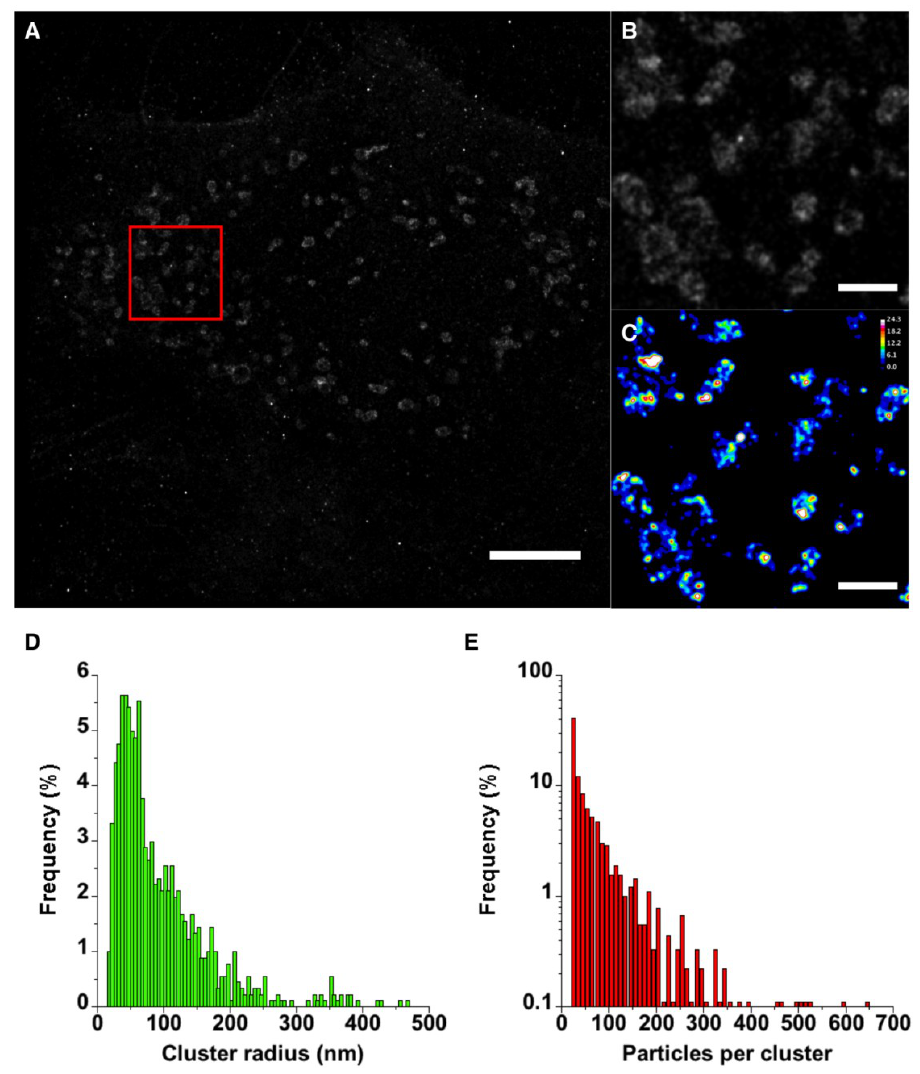
Figure 8. PALM imaging of vMIA-PAmCherry1. HFFs were transfected with vMIA-PAmCherry and imaged by PALM. ( A ) The image shows 301666 molecules that were localized to ≤25 nm precision out of 515207. Molecules are plotted as two-dimensional Gaussian distributions with 25 nm standard deviations. ( B ) The image shows a small region in ( A ) indicated by the red square. The molecule positions in a binary image were used in pair correlation analysis and the maximum g(r) derived from using each molecule as a reference point was plotted as the pixel values. ( C ) The image shows the same region in the red square color-coded to display the varying degrees of molecule densities. The Look Up Table (LUT) and calibration bar are included in the upper right corner. The distributions of cluster sizes ( D ) and the number of particles per cluster ( E ) were determined from the pair correlation analysis results. The maximum cluster radius was limited to 500 nm and the minimum number of particles per cluster was limited to 20. Please note that the Y axis in (E) is a log scale to better indicate the lower percentages at the higher particle numbers. The scale bar in ( A ) is 5 μm and in ( B , C ) is 1 μm. High resolution images of the entire field of view are available in the SOM (see Supplemental Figures S7, S10 and